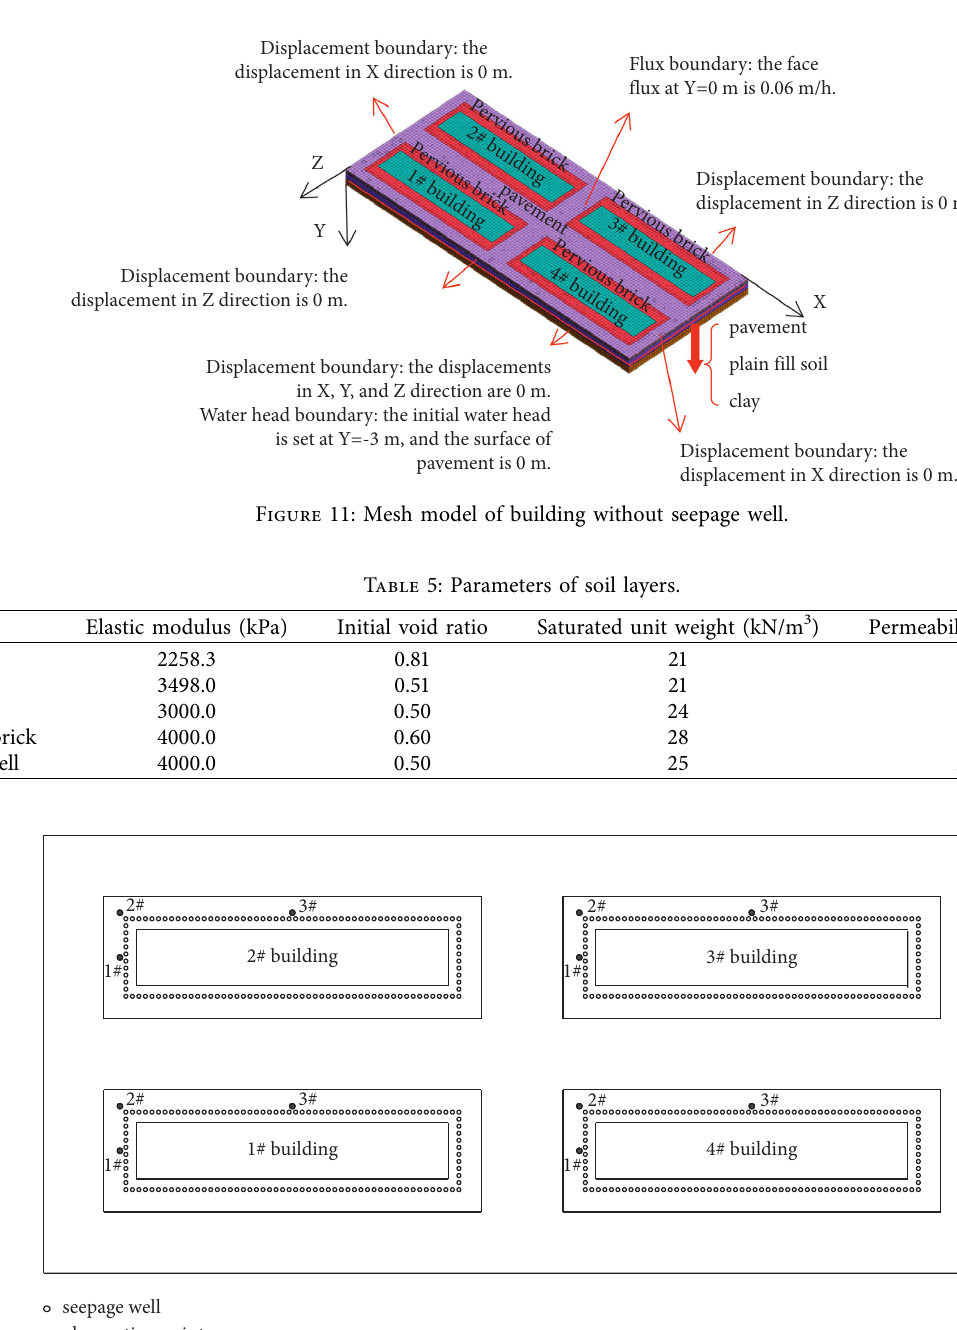
Figure 12: Buildings layout with seepage wells and observation points in the numerical model.